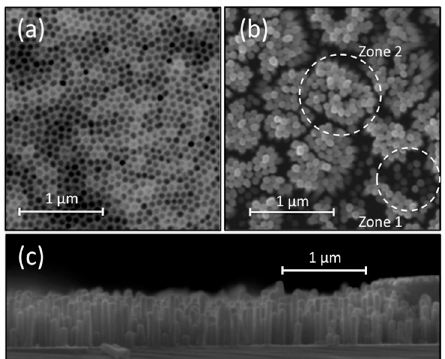
Figure 1. SEM micrographs. ( a ) Top view of the porous alumina membrane with Ni-Npillars electrodeposited inside the pores. ( b ) Top view and ( c ) side view of Ni-Npillars on Si substrate after removing the PAM template.